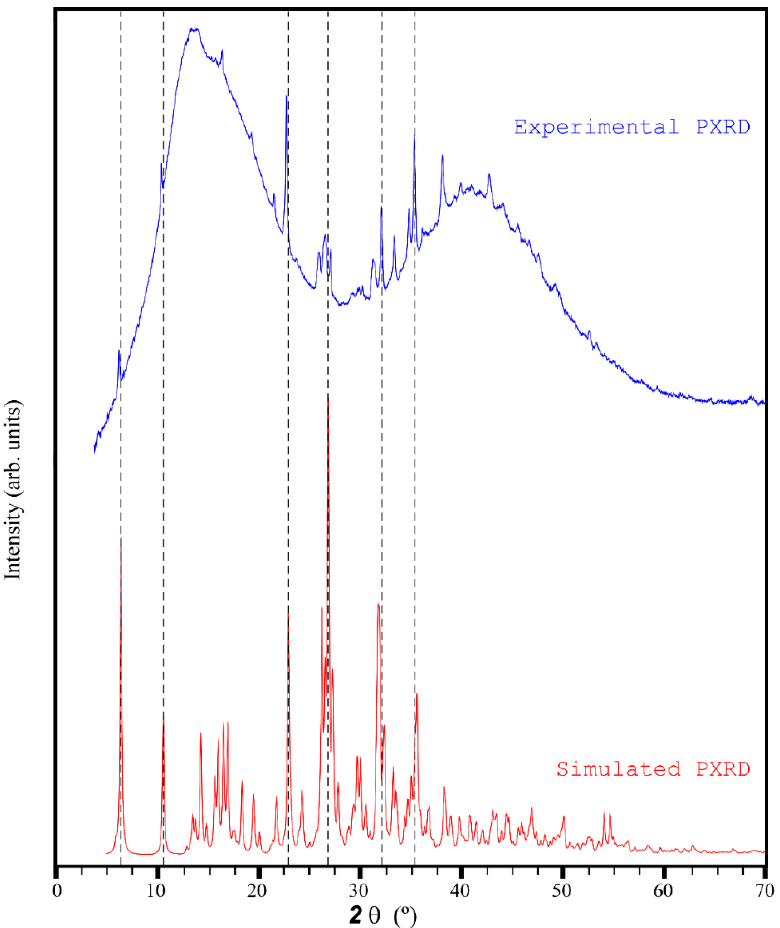
Figure 3. Comparison of the experimental and simulated PXRD patterns of Na-Pery.